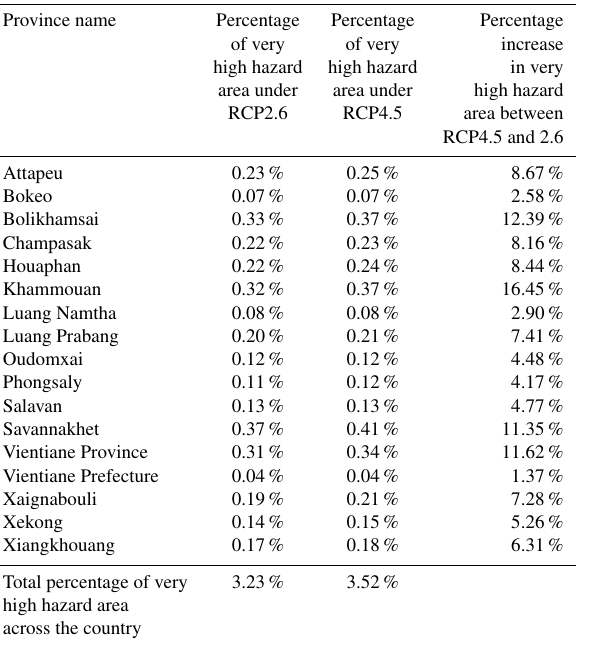
Table 5. Percentage of very high hazard area from the integrated hazard map in each province and the percentage of increase between the RCP8.5 and RCP4.5 scenarios during the far